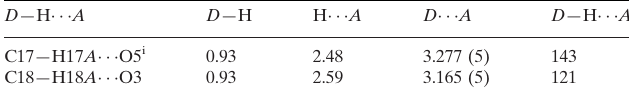
Hydrogen-bond geometry (A˚ , (cid:2) ). D —H (cid:3)(cid:3)(cid:3)